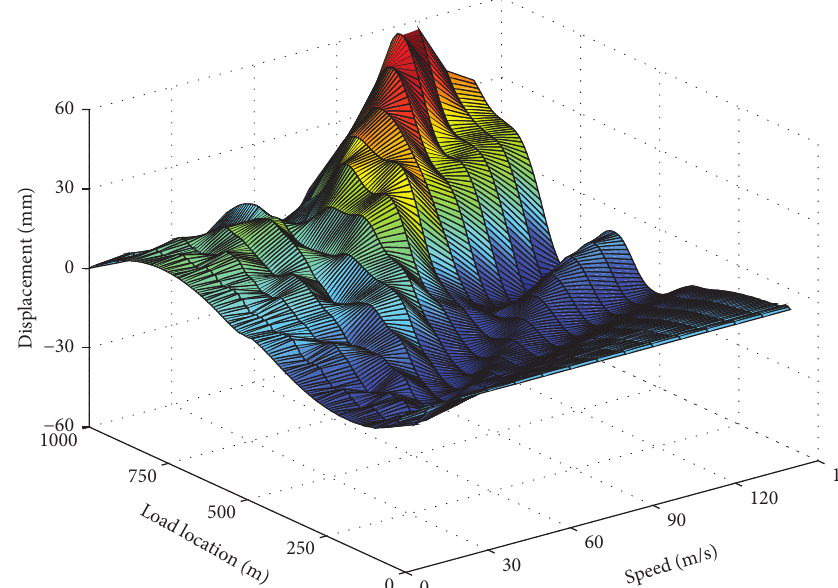
Figure 14: Longitudinal displacement at the end of the girder of the suspension bridge under a single moving